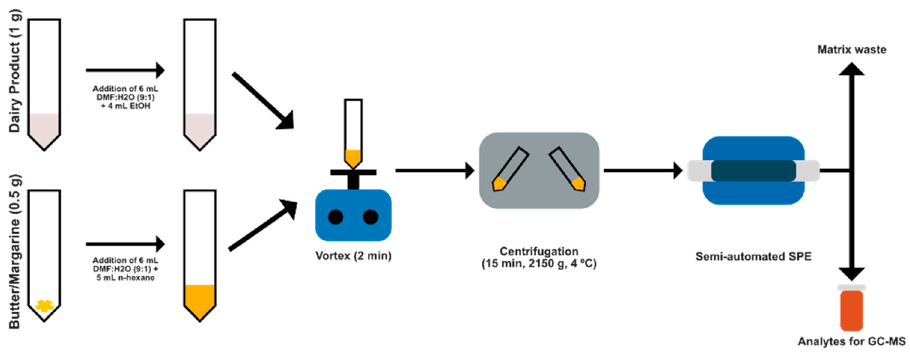
Figure 1. Procedure for determining polycyclic aromatic hydrocarbons in milk and dairy